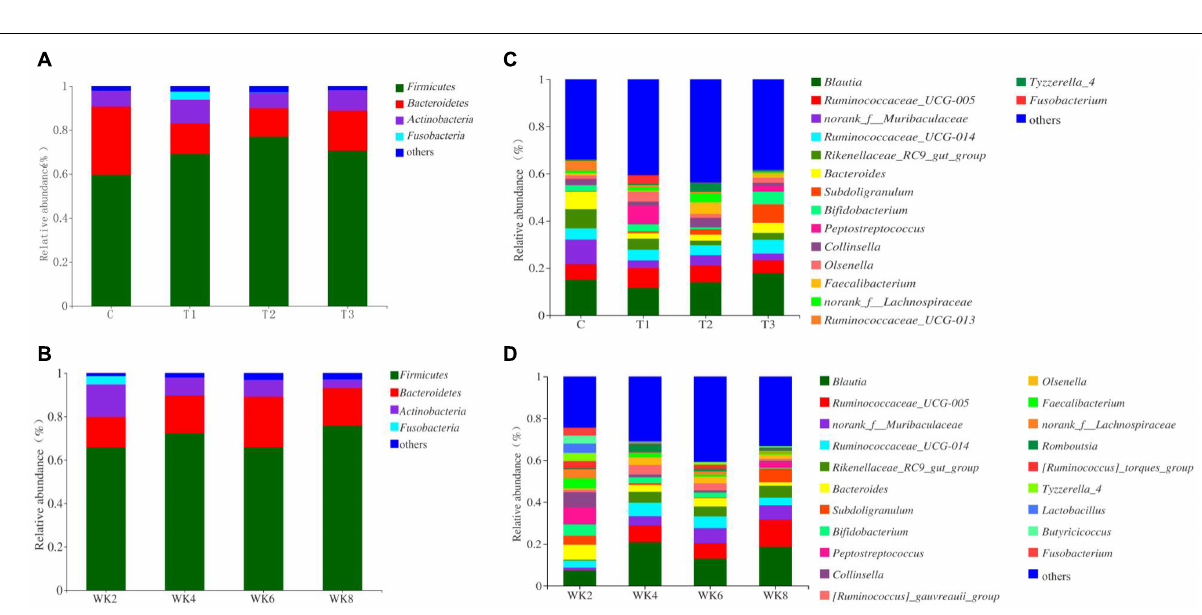
Frontiers in Microbiology |